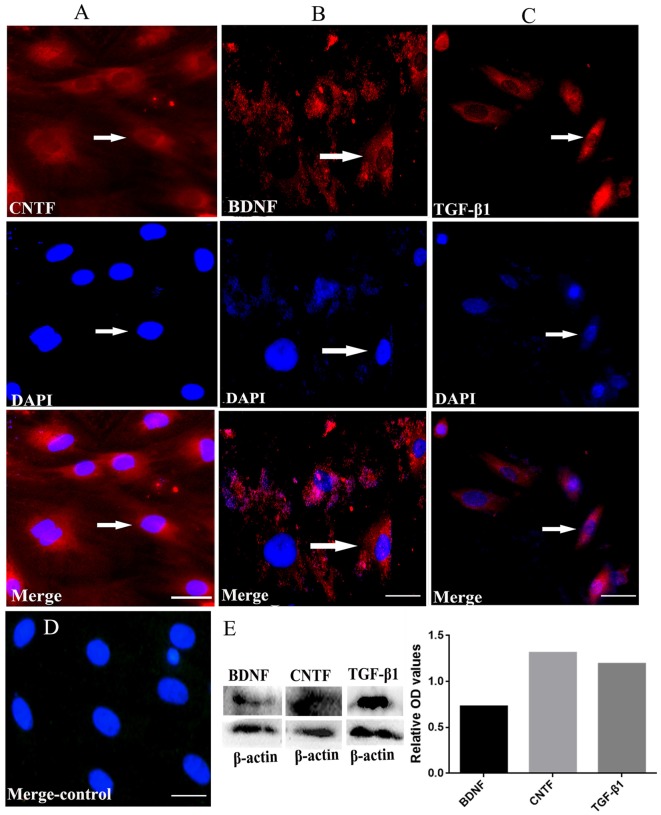
BMSCs could secrete NTFs in vitro revealed by immunofluorescent staining and western blots. (A, red, upper) Immunofluorescent staining of CNTF. (B, red, upper) Immunofluorescent staining of BDNF. (C, red, upper) Immunofluorescent staining of TGF-β1. (A–C, blue, middle) DAPI staining in each detection. The merged images for CNTF, TGF-β1 and BDNF were also showed in (A–C) respectively. (D) The merged negative control showed no positive fluorescence. Bar = 25 μm. White arrows represent the positive cells. (E) Western blots showed the true expression of NTFs including CNTF, TGF-β1 and BDNF secreted by the cultured BMSCs in vitro. BDNF, brain-derived neurotrophic factor; TGF-β1, transforming growth factor beta 1; CNTF, ciliary neurotrophic factor.